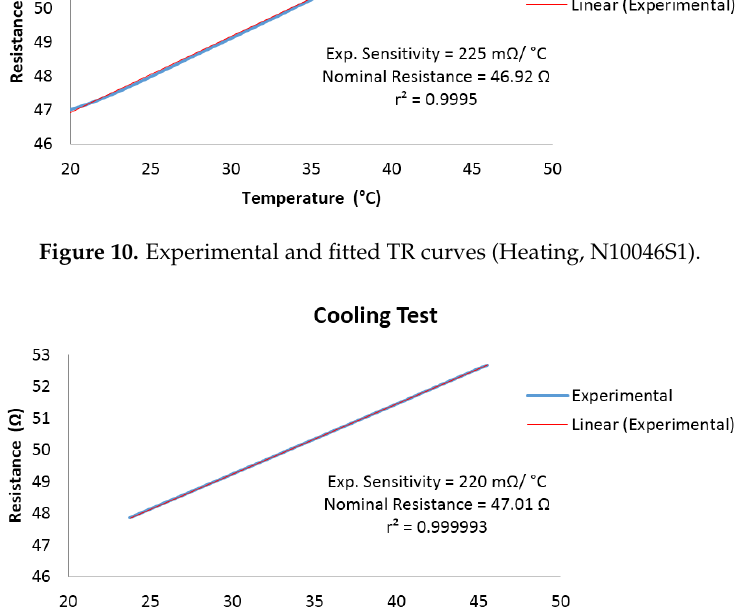
Figure 11. Experimental and fitted TR curves (Cooling, N10046S1).